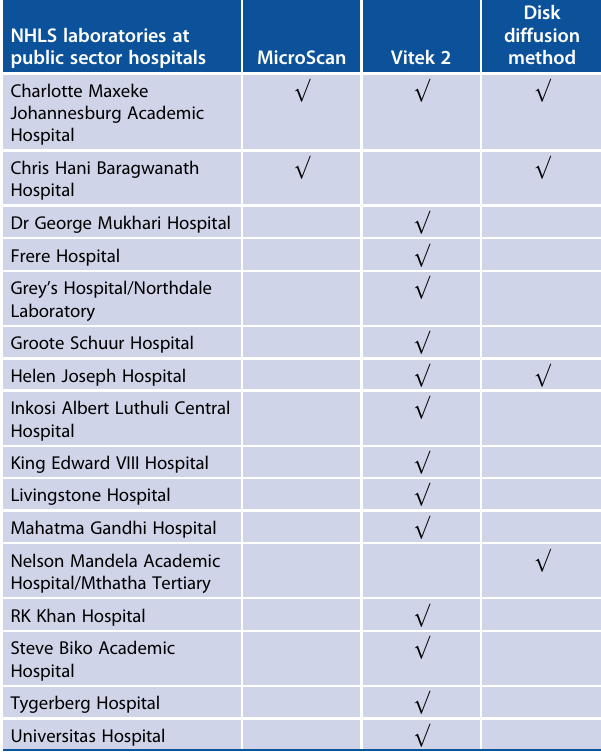
NHLS laboratories at public sector hospitals